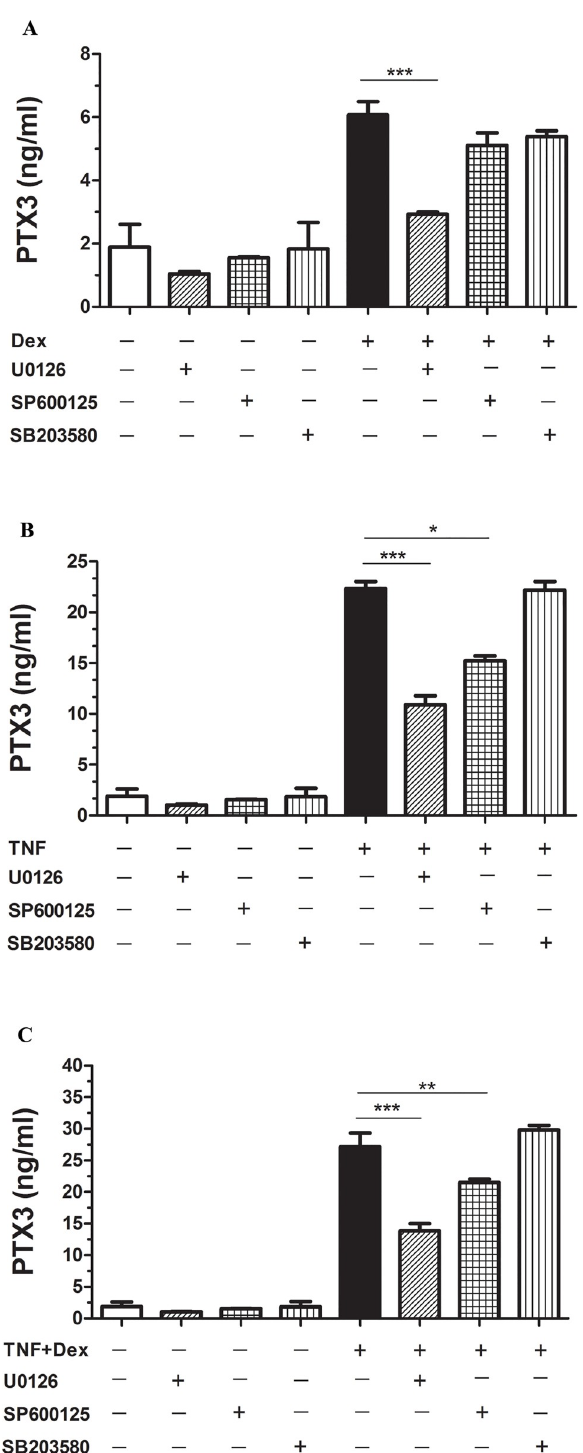
Fig 6. p42/p44 ERK MAPK inhibitors abrogate DEX mediated PTX3 release from HASMC. Growth-arrested cells were left unstimulated (medium alone), treated with DEX (1 μ M), TNF alone or combination, and with inhibitors of p38 MAPK (SB-203580, 10 μ M), p42/p44 ERK (U-0126, 10 μ M), JNK (SP-600125, 50nM) added 30 min before. Results are representative means ± SD of triplicate values from 3 different donors. � P < 0.05, �� P < 0.01 ��� P < 0.001, compared with DEX, TNF alone or DEX combined TNF stimulated